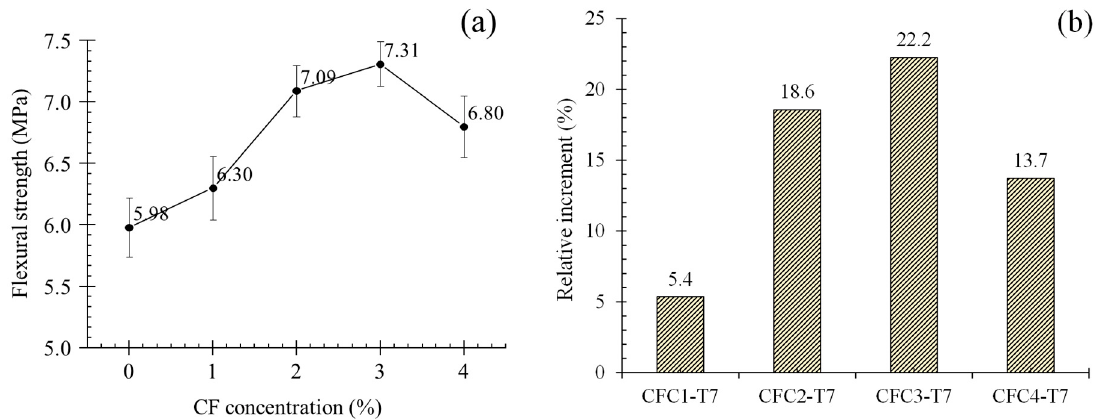
Figure 8. Average flexural strength and its relative increment at seven days: ( a ) average flexural strength; ( b ) relative increment.